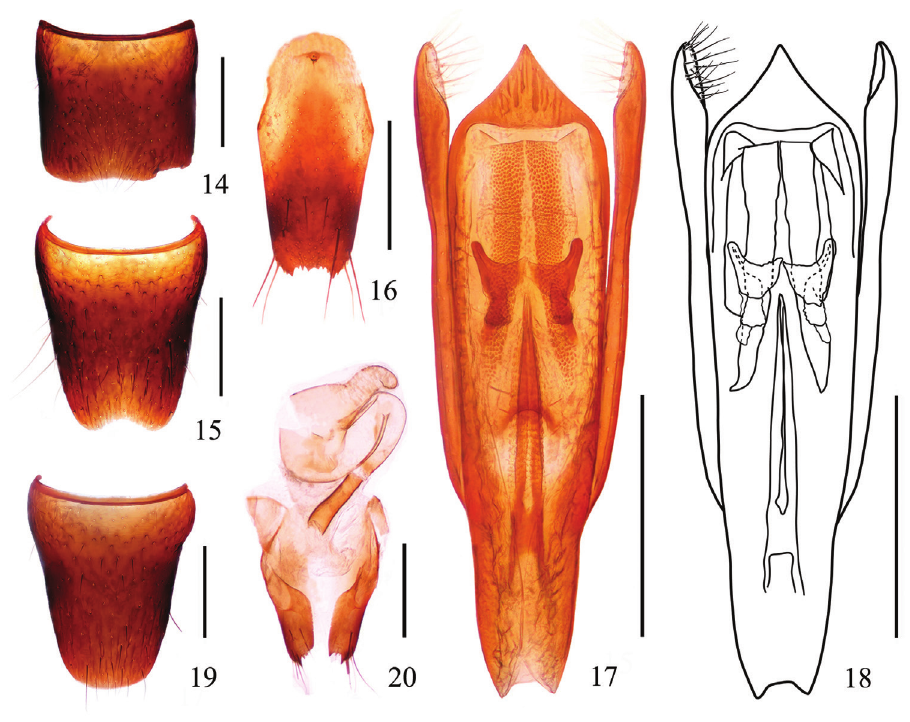
Figures 14–20. Stenus yuyimingi . 14 male sternite VII 15 male sternite VIII 16 male sternite IX 17, 18 aedeagus 19 female sternite VIII 20 valvifers and spermatheca. Scale bars: 0.25 mm.